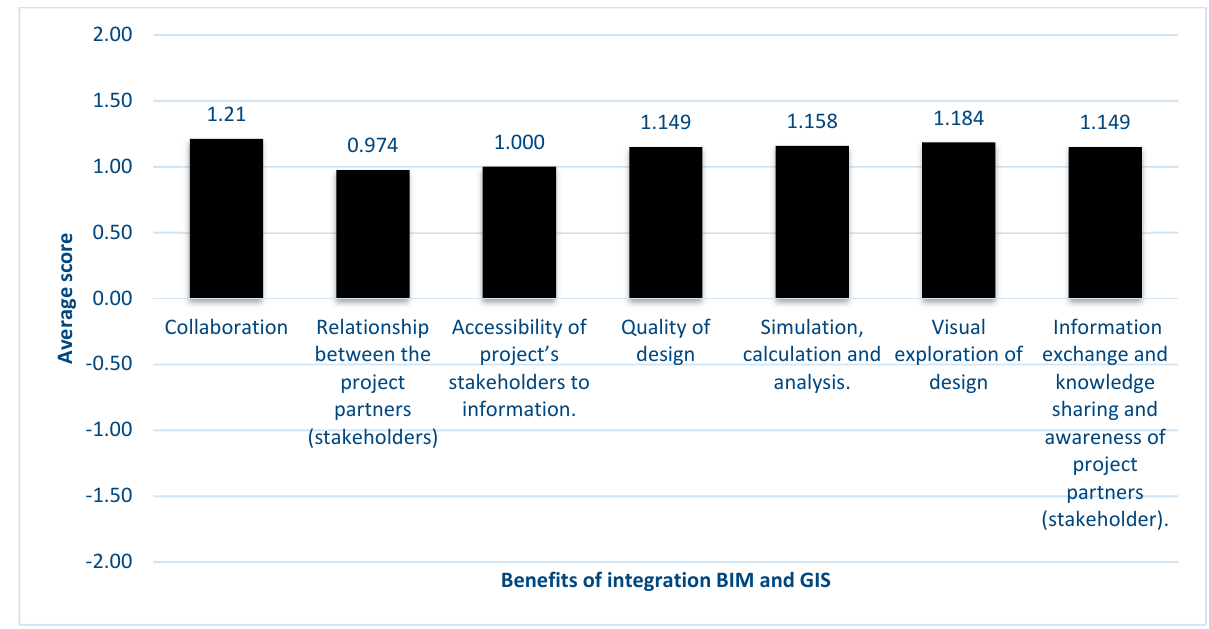
Figure 7. Benefits of Integration BIM and GIS in Design Stage.